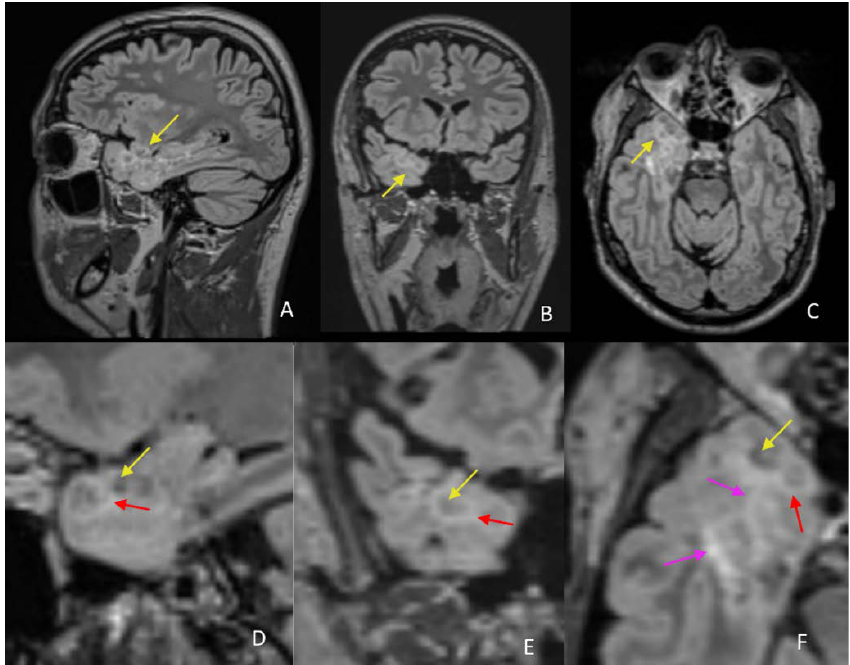
Figure 5. T2 FLAIR in sagittal ( A ), coronal ( B ), and axial ( C ) planes with correspondent zoomed images ( D – F ) on the temporal lesion reveals hypointense nodules at the cortical–subcortical white matter junction (yellow arrow) with a peripheral high signal intensity ring (red arrow) and areas of high signal intensity between them (pink arrow).